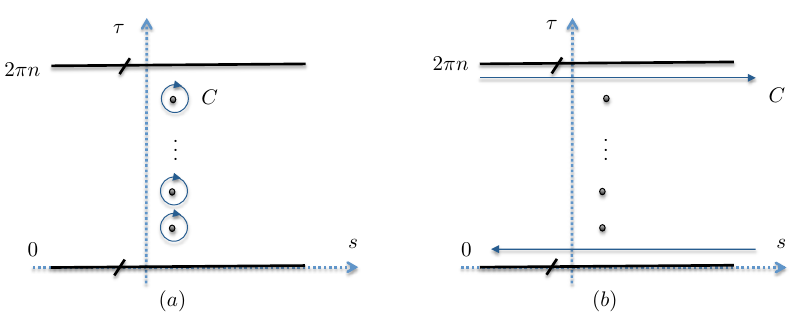
Figure 4 . (a) The path-integral over complexi(cid:12)ed (cid:28) picks up n poles at (cid:28) = 2 (cid:25)j . (b) The contour C is deformed to run over ( where s is the complexi(cid:12)ed (cid:28) angle. The contour C is deformed to run over (